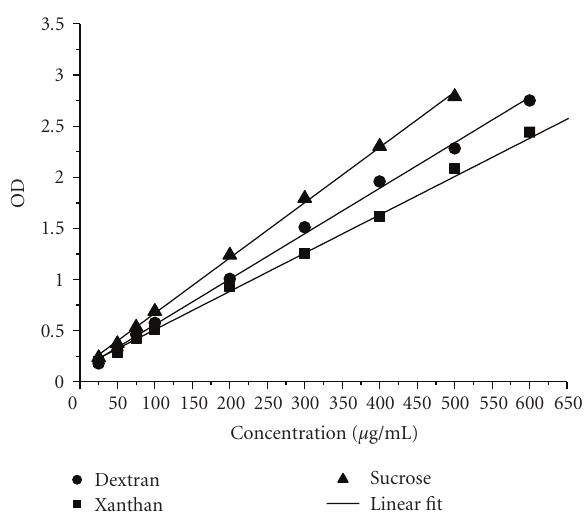
Figure 5: Dubois assay: mean values and mean-based 95% confidence intervals of carbohydrate concentration in S. mutans cultures of the white rectangle medium A without sucrose and the grey rectangle medium B with 5% sucrose at 24 h, 48 h, and 144 h incubation time.